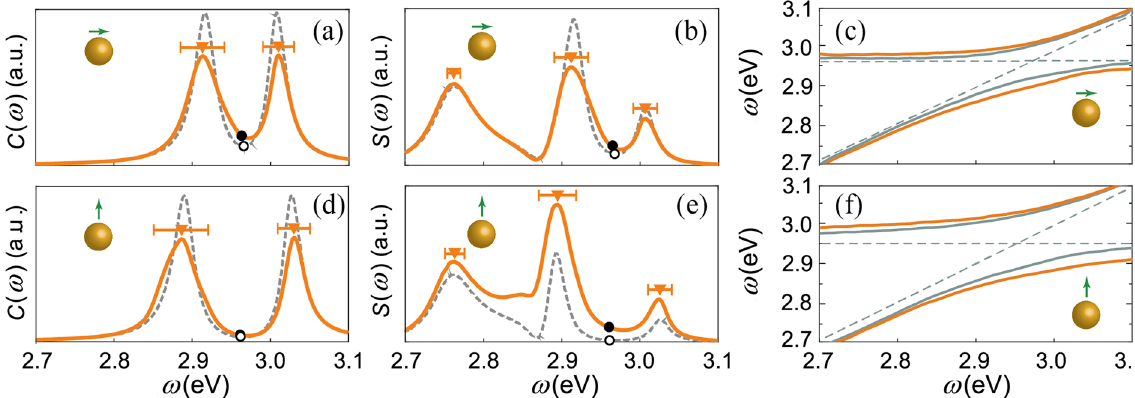
Figure 6. ( a ) LSES for idealized MNP (gray dashed line) and for rough MNPs on average (orange solid line). ( b ) FFDS for idealized MNP (gray dashed line) and for rough MNPs on average (orange solid line). ( c ) LSES spectral peaks as a function of frequency averaged over 100 random realizations of rough MNPs (orange solid line). LSES spectral peaks for idealized MNP are also shown (gray solid line). The gray dashed line represents the uncoupled transition frequencies. ( a–c ) x-oriented dipole. ( d – f ) z-oriented dipole. The upside-down triangle in the error bar indicates the peak frequency, and the error bar indicates the standard deviation of the mean. Transition frequencies are indicated by black dots and hollow dots on the curves for MNPs with a bump and idealized MNP,